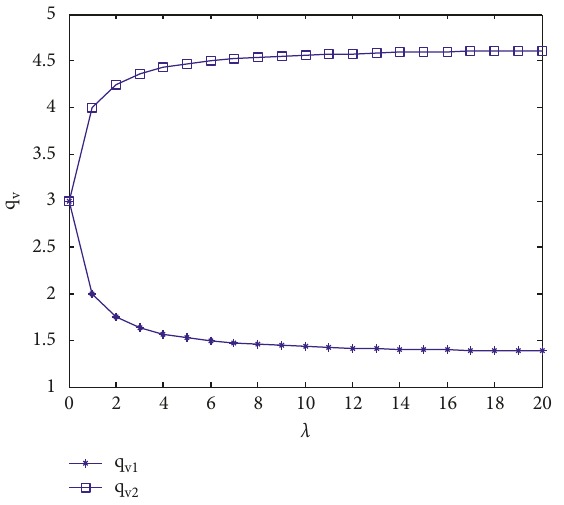
Figure 3: Impacts of vertical fairness concern on the ordering